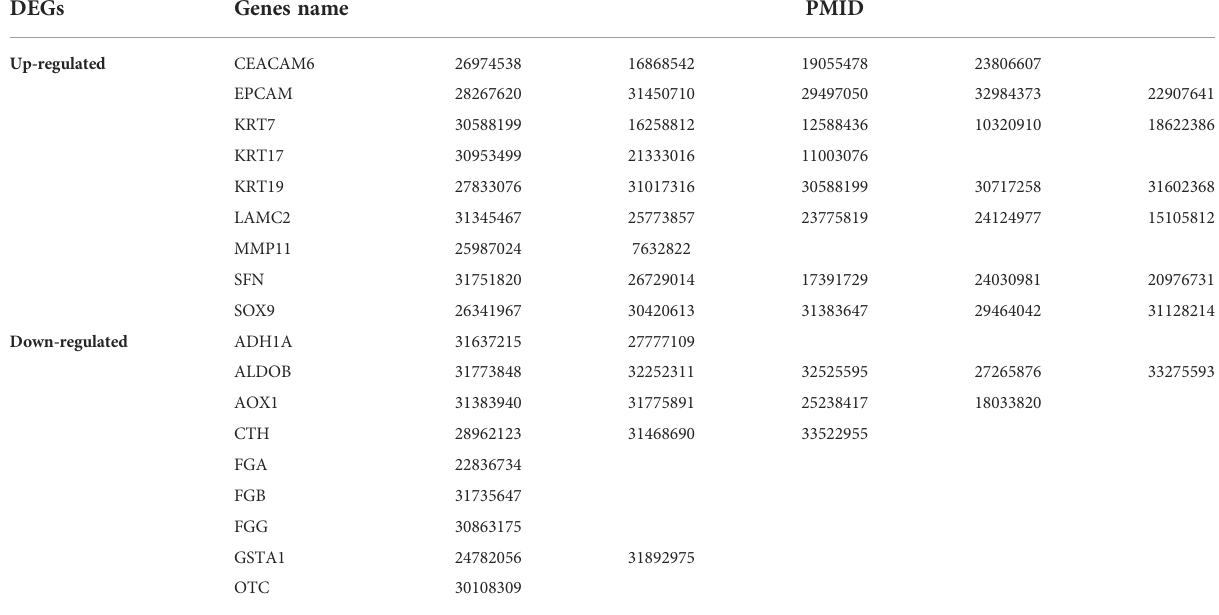
TABLE 4 Selected DEGs with clinical relevance with PubMed